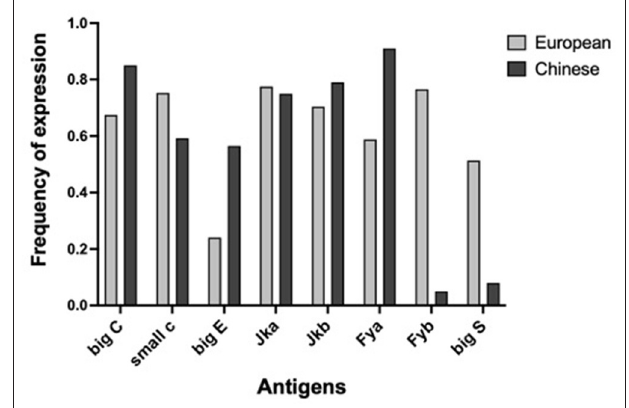
FIGURE 2 | Comparison between the expression frequency of human minor blood group antigens of European database (gray) and Chinese database (black). Marked differences are present regarding to Fya, Fyb, big S, and big E antigens.